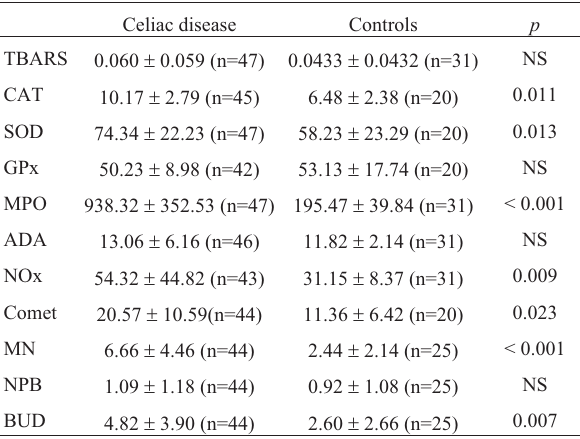
Table 1 - Markers of oxidative stress, inflammation and DNA damage in patients with celiac disease and controls. Celiac